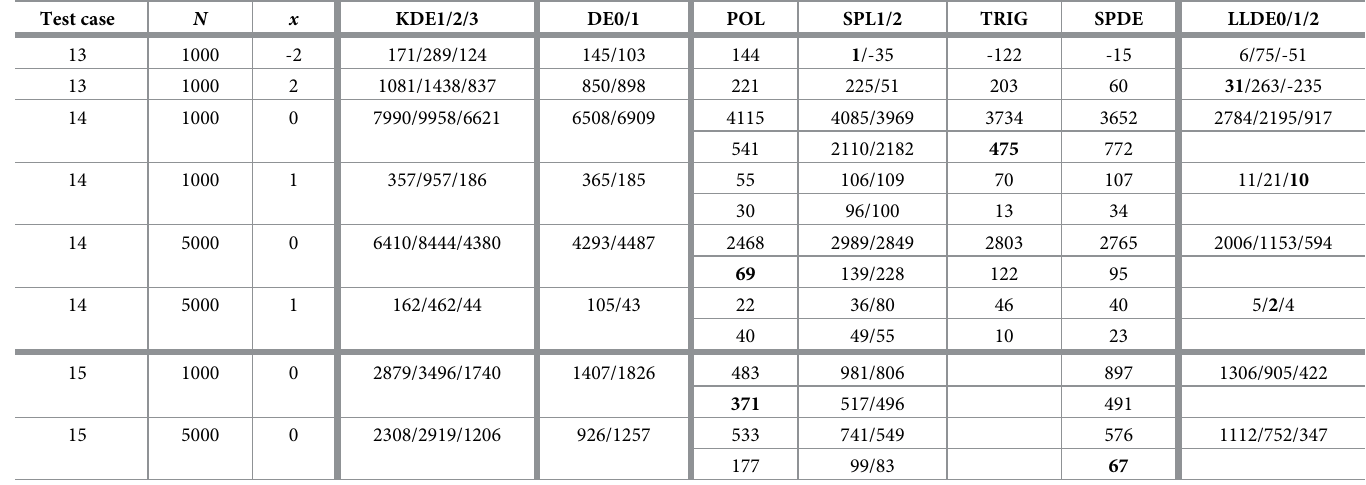
Table 9. Boundary bias (scaled by 10 4 ) estimated as the mean over 100 realisations. The true density at the boundary is f 13, f X (0) = f X (1) = 0 for test case 14, and f X (0) = 0 for test case 15. For the semiparametric estimators and test cases 14 and 15, the upper row refers to models without boundary terms and the lower row to models allowing for logarithmic boundary terms at any boundary point. The best method is indicated in